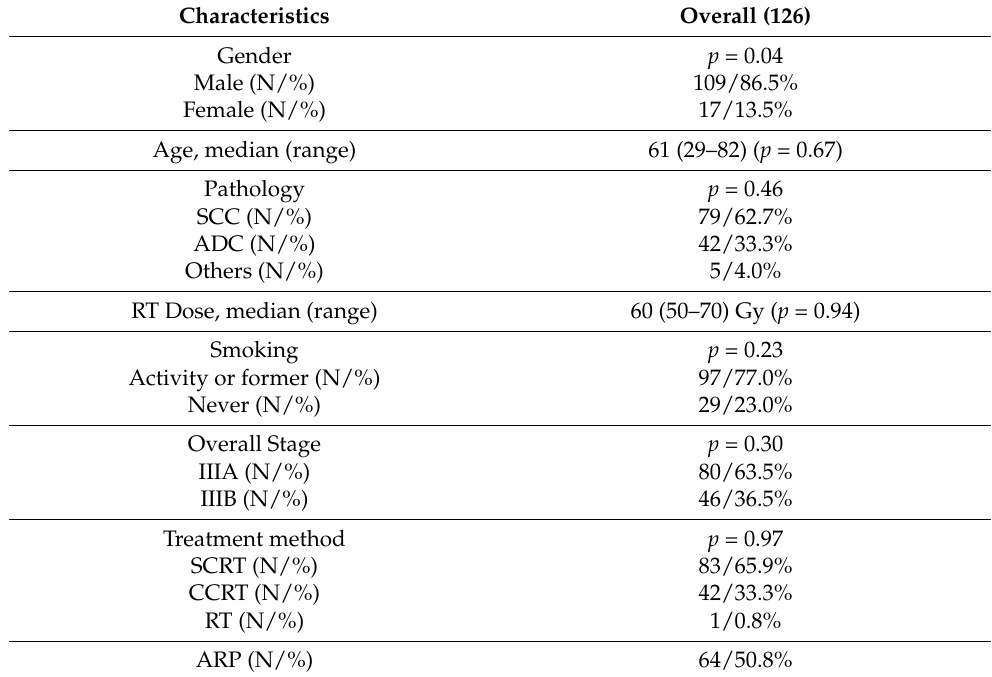
Table 1. Patient characteristics.